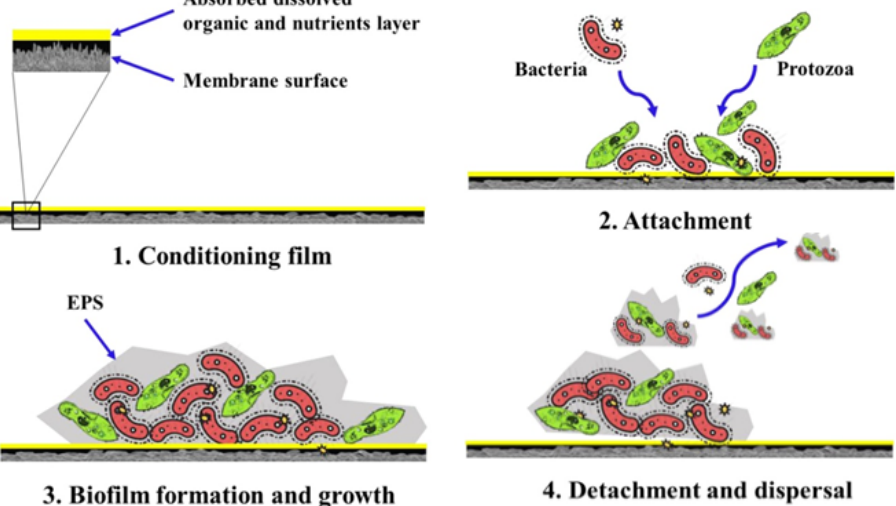
Figure 3. The formation and development of biofouling ( 1 → 4 ) in a membrane-based process for water and wastewater purification. Diagram taken from [65].